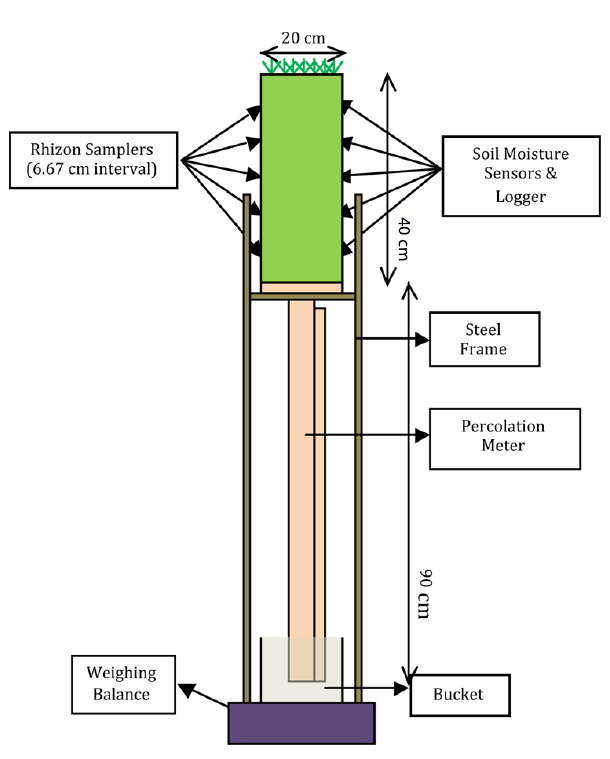
Fig. 1. Schematic sketch of the experimental set-up.